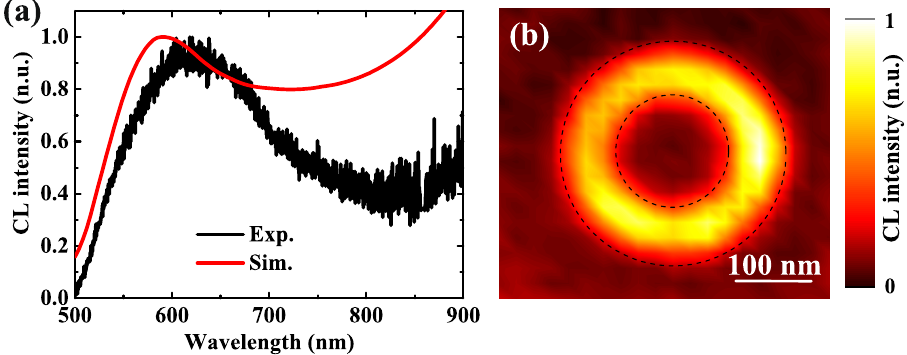
Figure 3. Comparison of the measured and calculated CL spectra, and the normalized CL map. ( a ) Measured (black) and calculated (red) CL spectra for r = 80 nm nanoring excited by 15 keV electrons at the position of r = 120 nm. ( b ) The CL intensity as a function of excitation position for the same nanoring at λ = 604 nm, integrated over a 20 nm bandwidth. The black dashed circle indicates the edge of the nanoring.